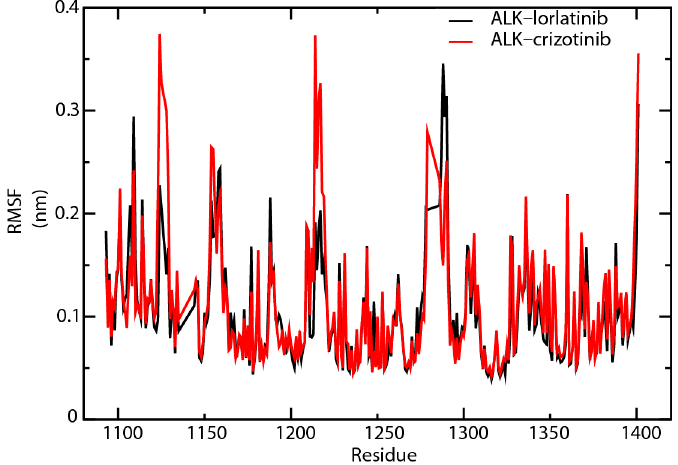
Figure 7. Root-mean-square fluctuation (RMSF) comparison of ALK–inhibitor complexes. Amino acid residues of crizotinib-associated (red line) or lorlatinib-associated (black line) ALK proteins were analyzed for RMSF.